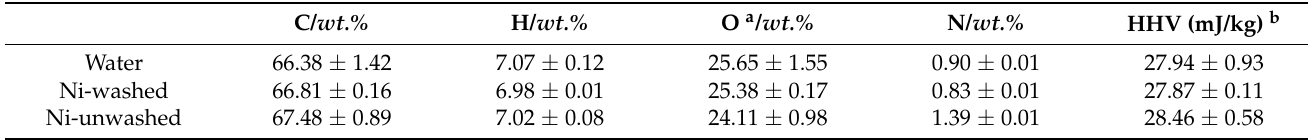
Table 3. Element Analysis of bio-oil derived from pyrolysis. C/ wt.% H/ wt.% O a /